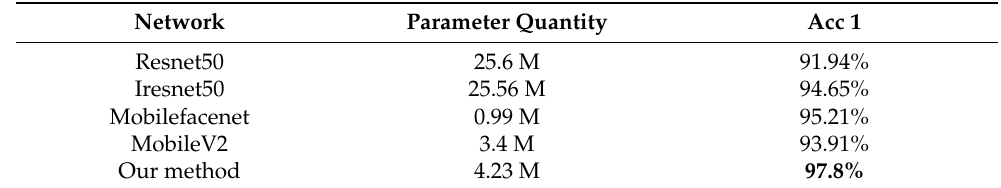
Table 5. Performance comparison of different